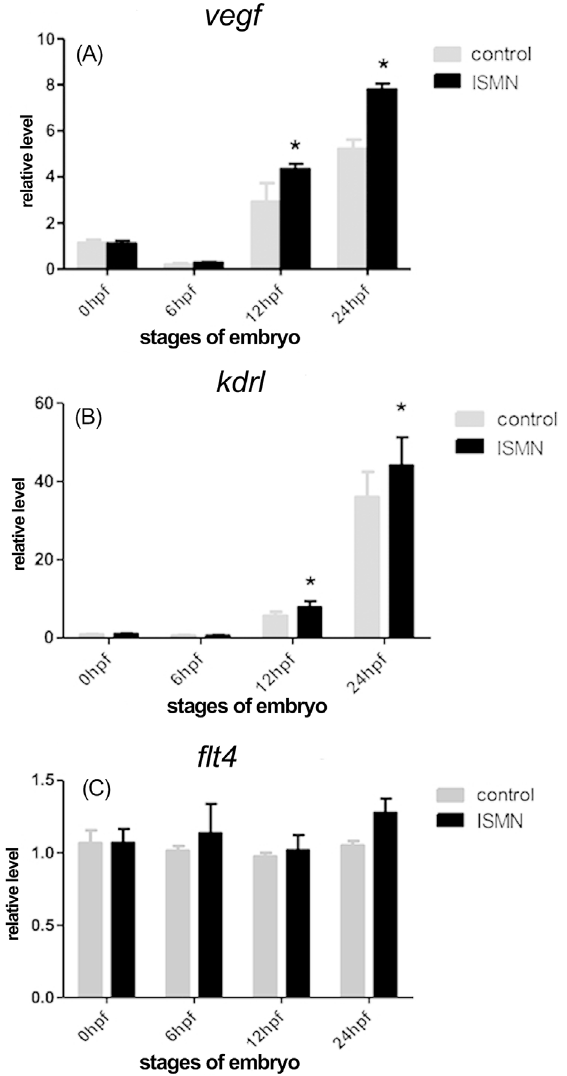
Figure 3 - Analysis of target genes involved in VEGF signaling pathways inISMN-treatedzebrafishembryos.(A)Relativeexpressionof vegf-a .(B) Relative expression of vegfr-2 ( kdrl ). (C) Relative expression of vegfr-3 ( flt4 ). Data were expressed as mean (cid:5) SD (n = 3). * p < 0.05.